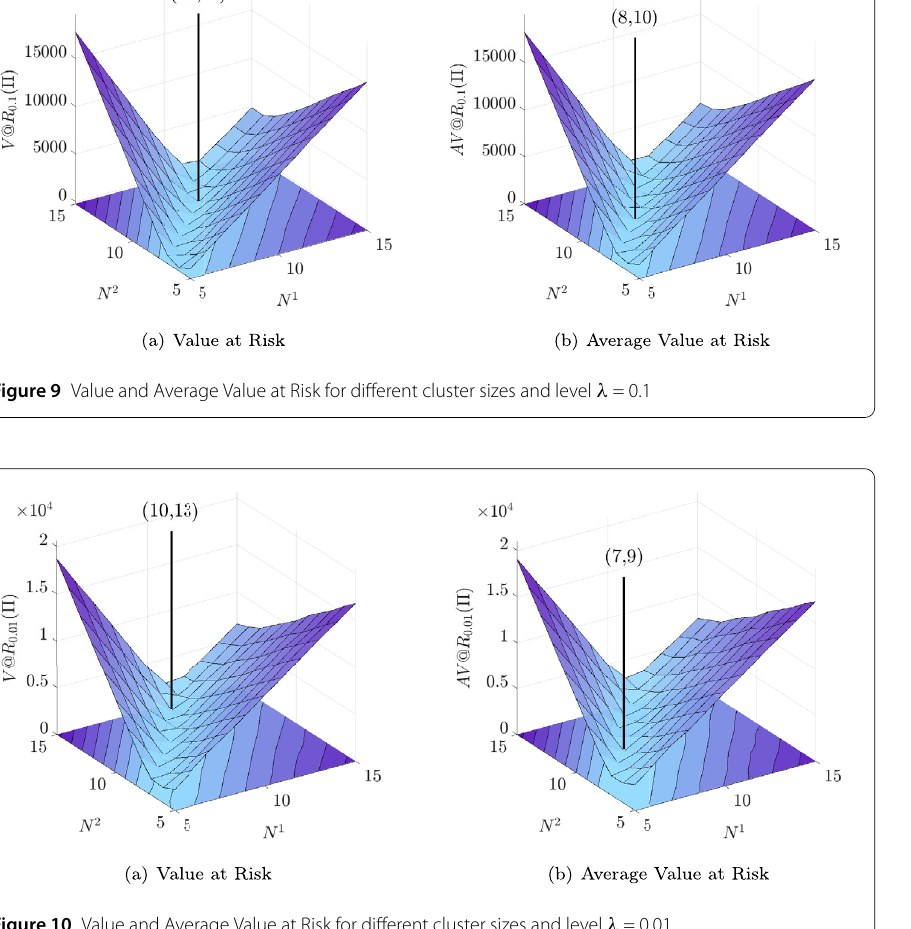
Figure 10 Value and Average Value at Risk for different cluster sizes and level λ =